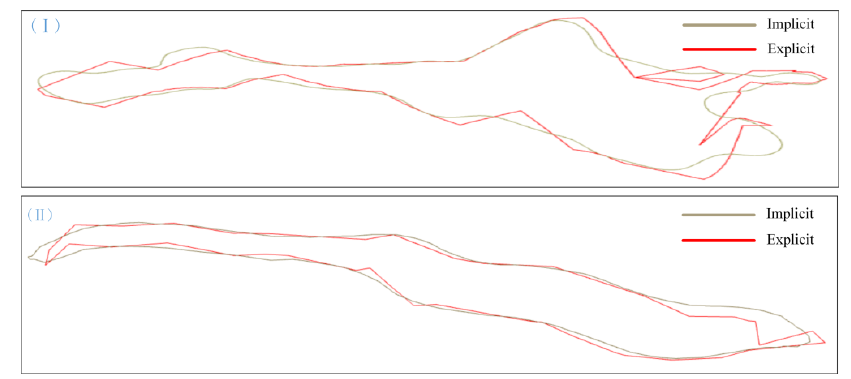
Figure 10. Explicit Model and Implicit Model for Case I and Case II.